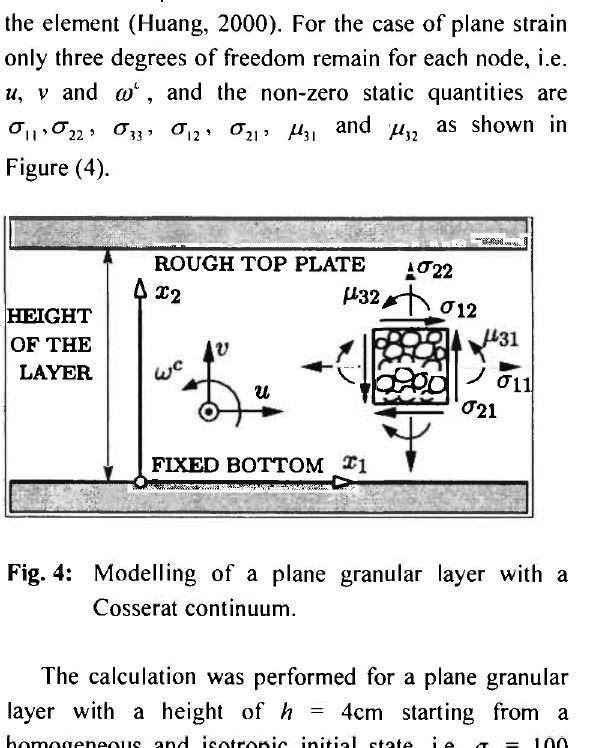
Fig. 4: Modelling of a plane granular layer with a Cosserat